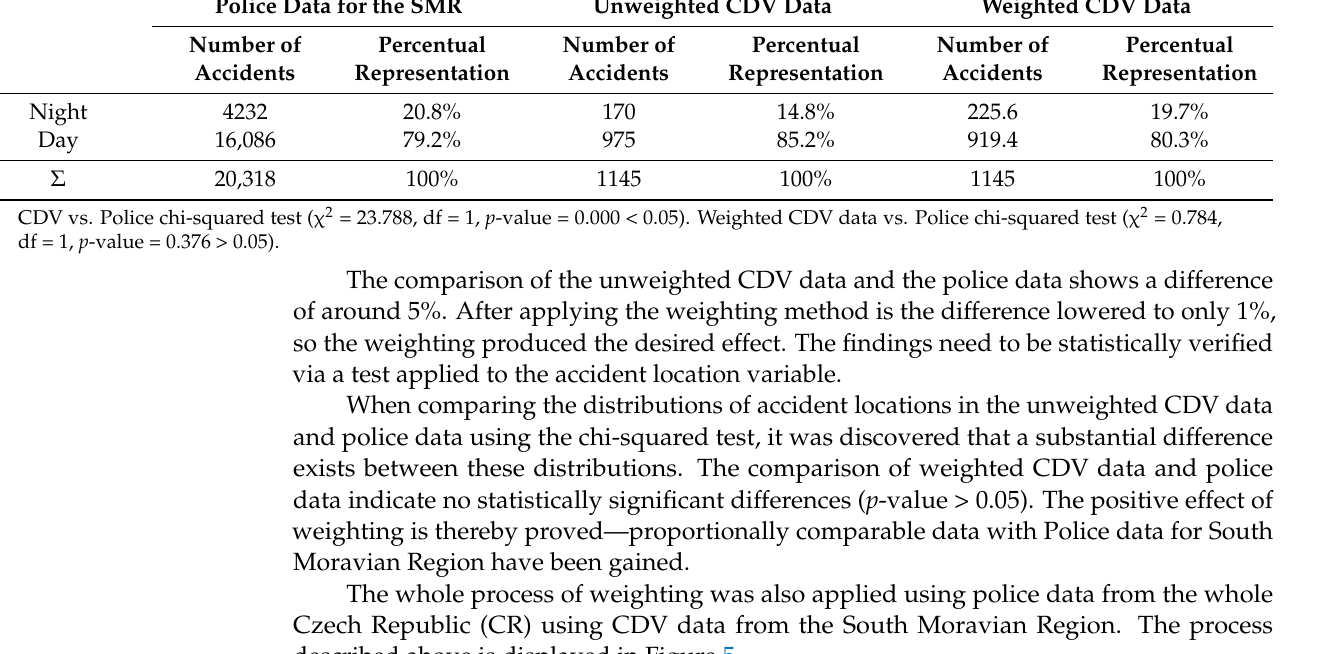
Table 2. Resulting weighted values for the accident daytime variable in the South Moravian Region. Police Data for the SMR